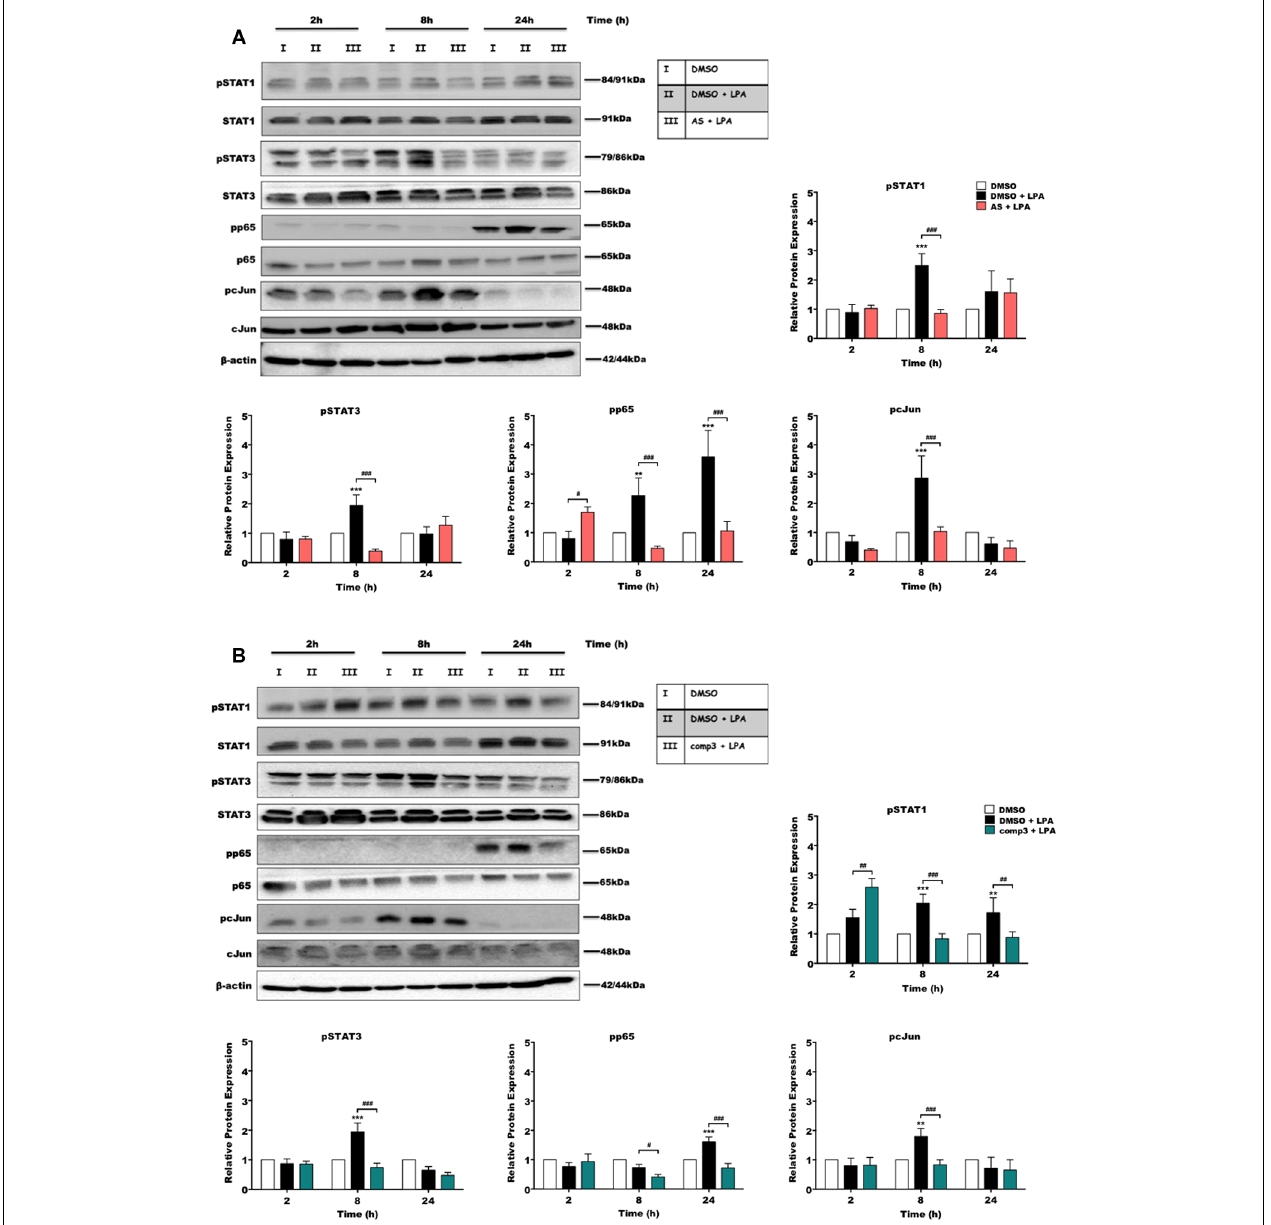
FIGURE 2 | AS2717638 and compound 3 attenuate lysophosphatidic acid (LPA)-induced phosphorylation of pro-inflammatory transcription factors. BV-2 microglia cells were cultured in 6-well plates and serum-starved o/n. Cells were treated with DMSO, DMSO plus LPA (1 µ M), and LPA (1 µ M) in the presence of (A) AS2717638 (0.1 µ M) or (B) compound 3 (1 µ M) for the indicated time periods and cell protein lysates were collected. The phosphorylation states along with the total levels of STAT1, STAT3, p65-NF-kB, and c-Jun were detected using Western blotting. If two bands appeared for one protein [e.g., (p)STAT3] both bands were included in the densitometric evaluation. Protein/loading control ratios were normalized to the ratio of unstimulated microglia (mean value of DMSO controls was set to 1). One representative blot out of three separate experiments and the densitometric analysis of each protein expression from three independent experiments is presented ( ∗∗ p < 0.01; ∗∗∗ p < 0.001 compared to DMSO-treated cells; # p < 0.05; ## p < 0.01; ### p < 0.001 each inhibitor compared to LPA-treated cells; one-way ANOVA with Bonferroni